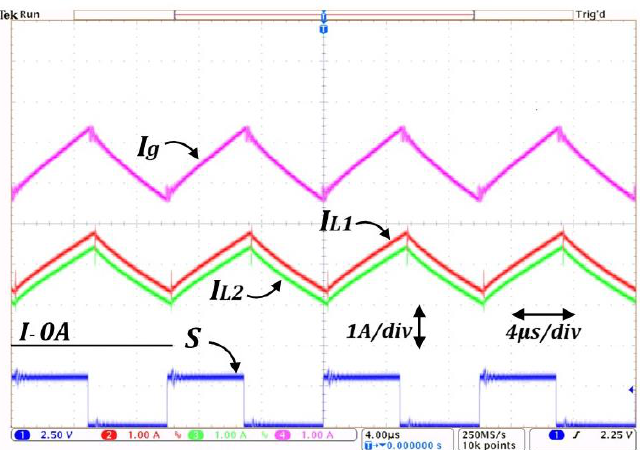
Figure 23. From button to top: the switching function of the transistor s, current through inductors, and input current when V g = 100 V , V o = 200 V , P o = 400 W .